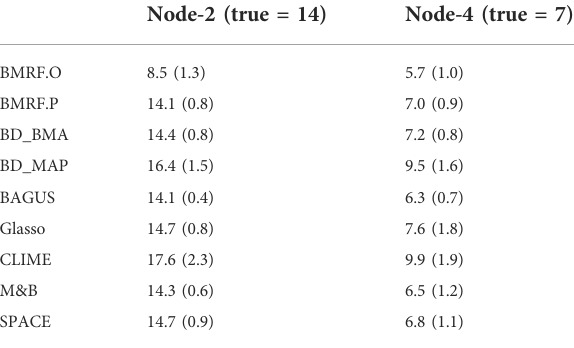
TABLE 2 The listed values are the average number of estimated edges connecting to each of the two hub nodes (Node-2 and Node-4) across 100 replications under M3. The number in parenthesis is the standard error. The true number of edges connecting to Node-2 is 14 and to Node-4 is 7.